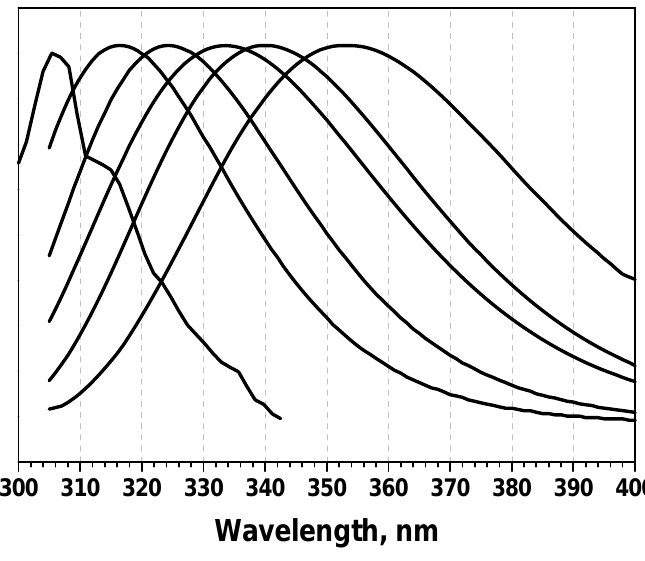
Figure 1. Examples of protein fluorescence spectra of tryptophan residues located in different environments of protein molecule. The position of maximum of fluorescence spectra can vary in range of 305 to 355